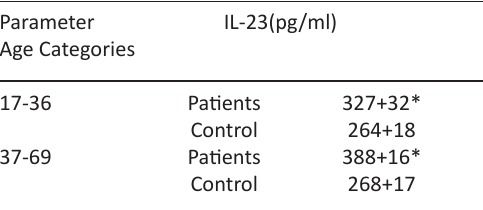
Table 6. Concentration of IL-23 pg/ml in patients with Brucellosis and healthy